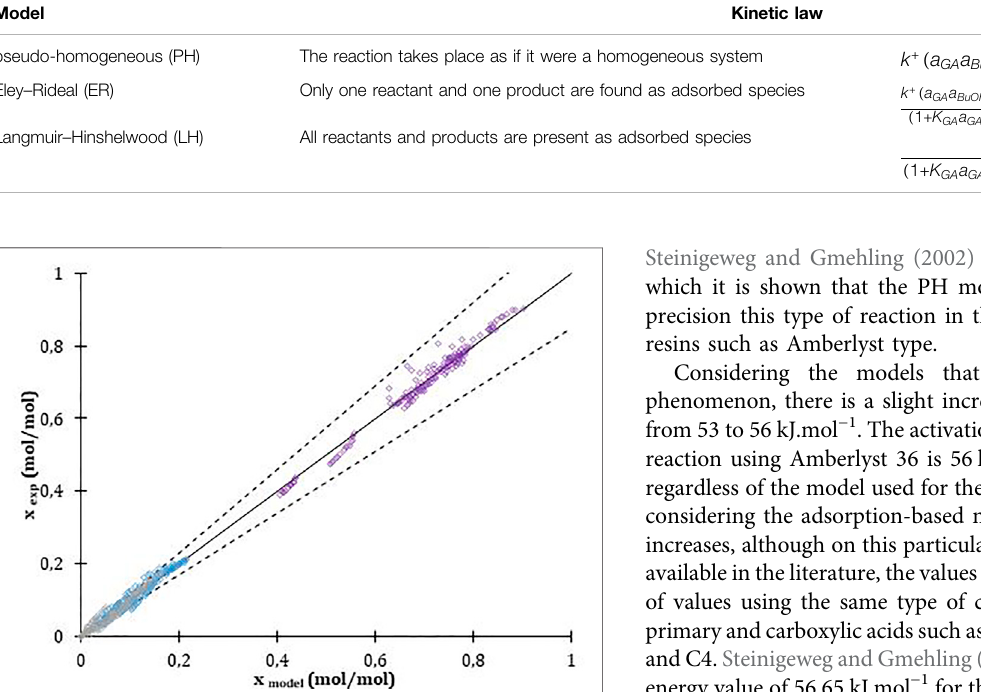
TABLE 3 | Kinetic models for esteri fi cation reaction. Model